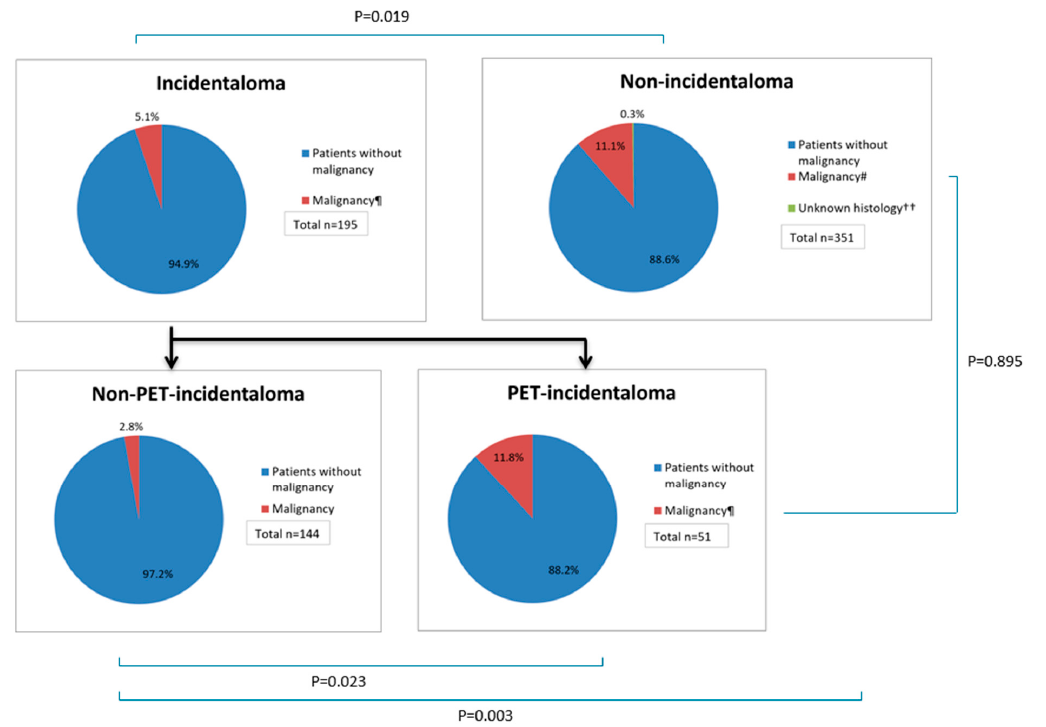
Figure 4. Proportion of malignant tumors among the whole study population. “¶” including 2 patients who had proven malignancy but did not receive surgery. # including 3 patients who had proven malignancy but did not receive surgery. †† including 2 patients who received surgery in a different hospital and 1 who refused surgery.